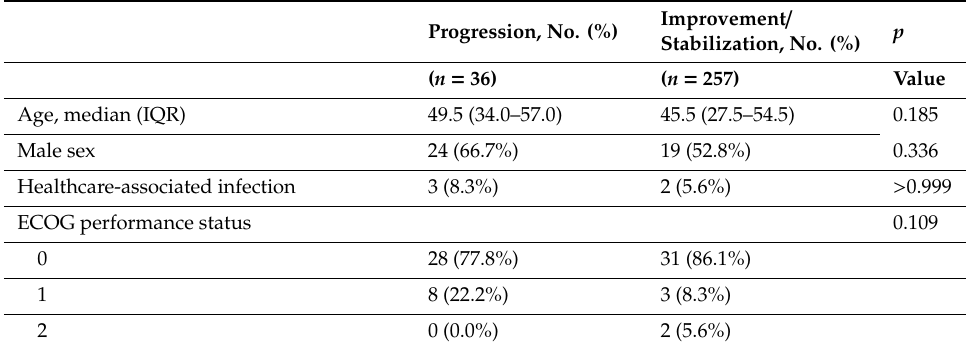
Table 2. Baseline characteristics of patients with COVID-19, after propensity-score matching